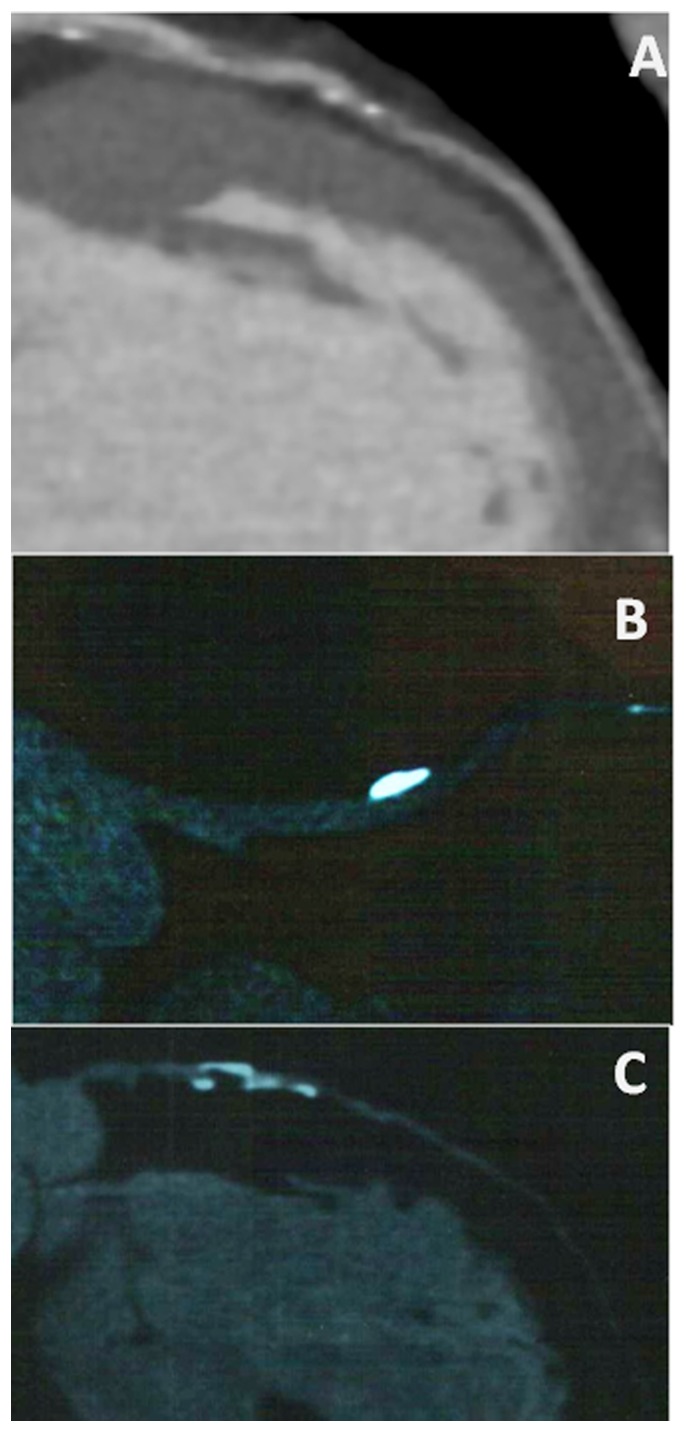
Coronary calcification was grouped as follows: spotty, length of calcium <3/2 of the vessel diameter and width <2/3 of the vessel diameter (A); medium, length of calcium ≥3/2 of the vessel diameter and width <2/3 of the vessel diameter or length of calcium <3/2 the vessel diameter and width ≥2/3 of the vessel diameter (B); and heavy, length of calcium burden ≥3/2 of the vessel diameter and width ≥2/3 of the vessel diameter (C).